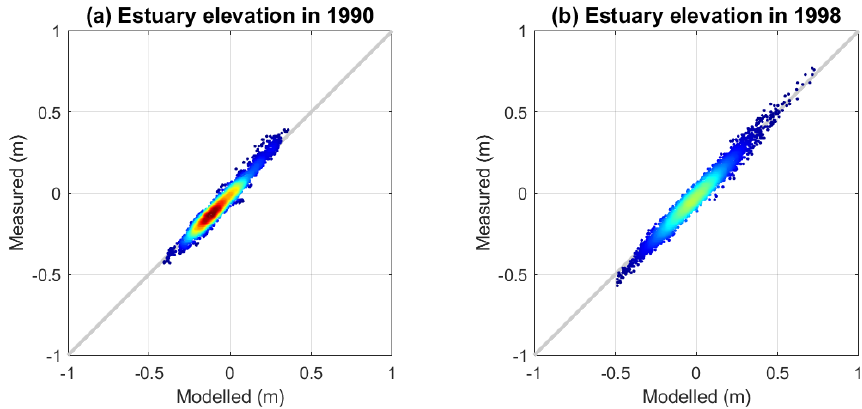
Figure 6. Modelled vs. measured surface elevation in the centre of Peel Inlet in (a) 1990 ( r = 0 . 9795) and (b) 1998 ( r = 0 . 9841). The grey line indicates the 1 : 1 ratio; the colour from blue to red indicates the data density from minimum to maximum.